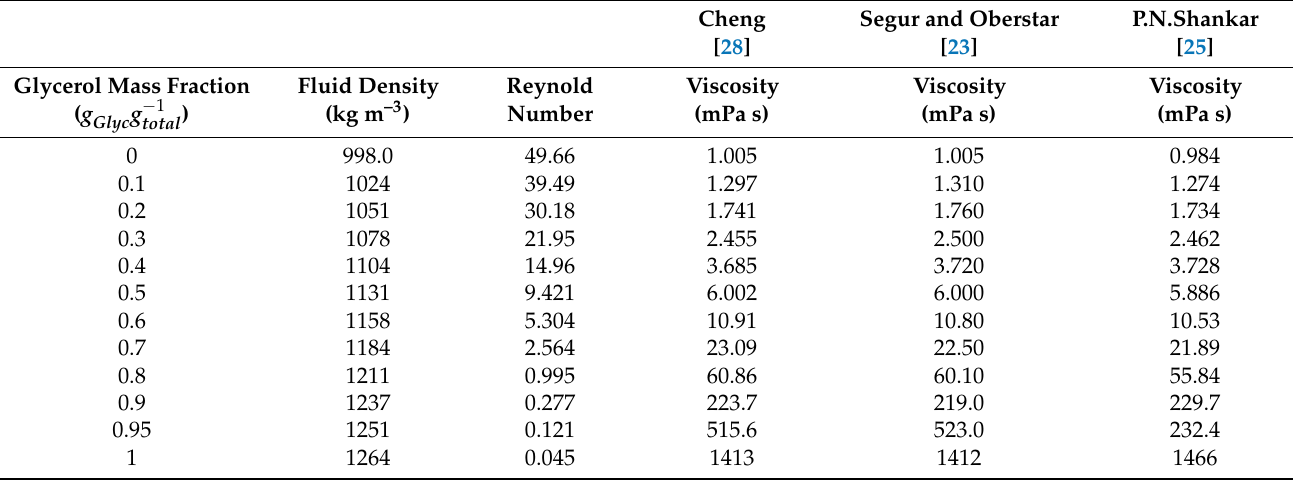
Table A2. Properties of working fluid at 20 ◦ C. The Reynolds numbers were calculated for a flow of 3mL/min in each inlet and using the calculation of density of glycerol-water mixture at 20 ◦